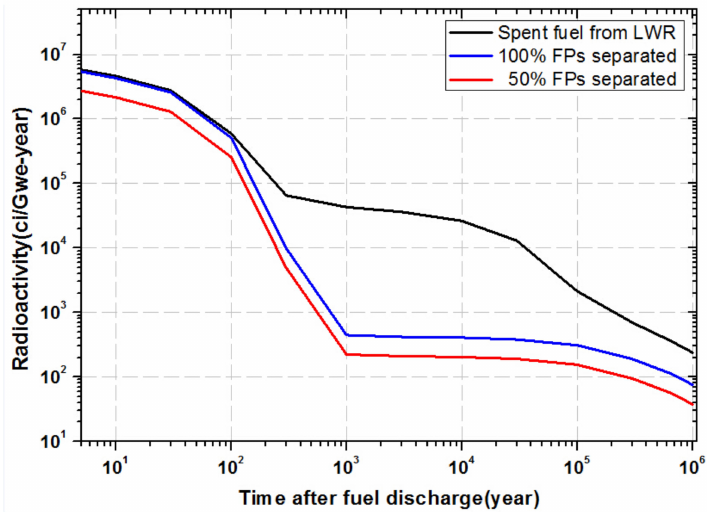
Figure 7. Relative values of radioactivity of the SNFs from LWR and fission products (FPs) separated after